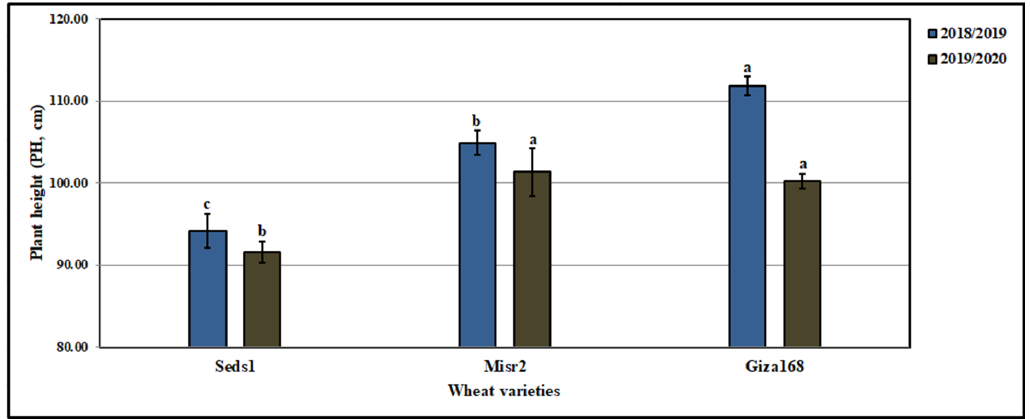
Figure 4. Influence of wheat varieties on plant height (PH, cm) in clay loam soil in 2018/2019 and 2019/2020 seasons. Bars in the same years with a different letter indicate significant differences between treatments at p ≤ 0.01.